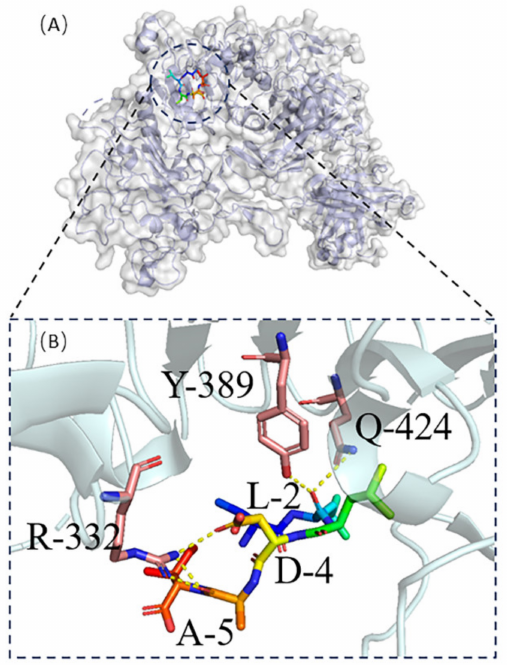
Figure 6. ( A ) Protein No. 7-HER2 complexes, ( B ) The active residues around Protein No. 7 binding to HER2 complexed with the Herceptin antigen-binding fragment.